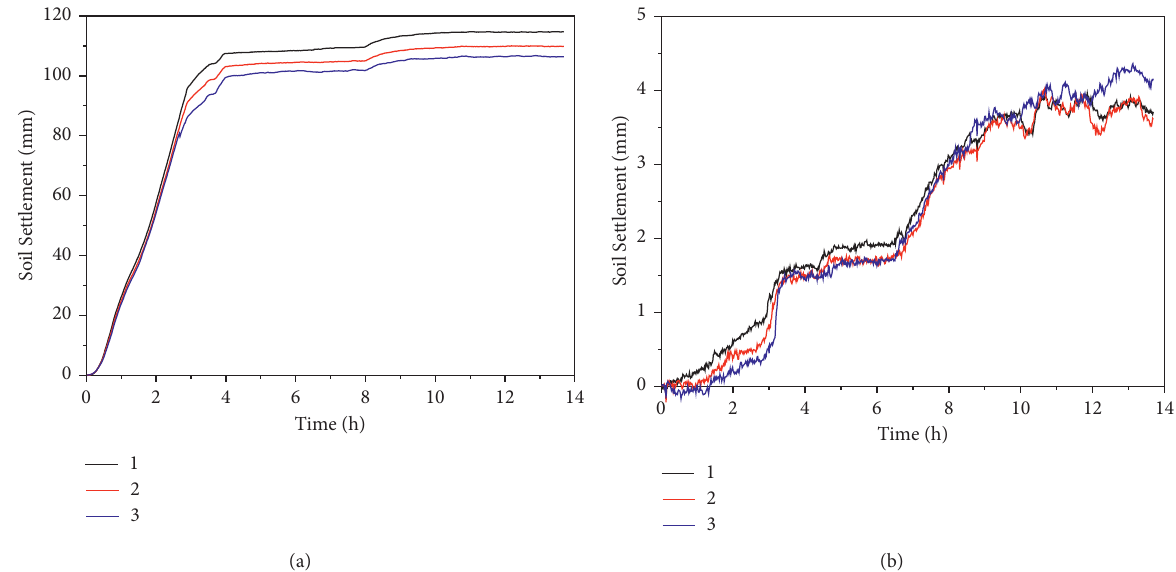
Figure 11: Average settlement of certain measure points of surface soil versus time. (a) Pile load: 12kN. (b) Pile load: